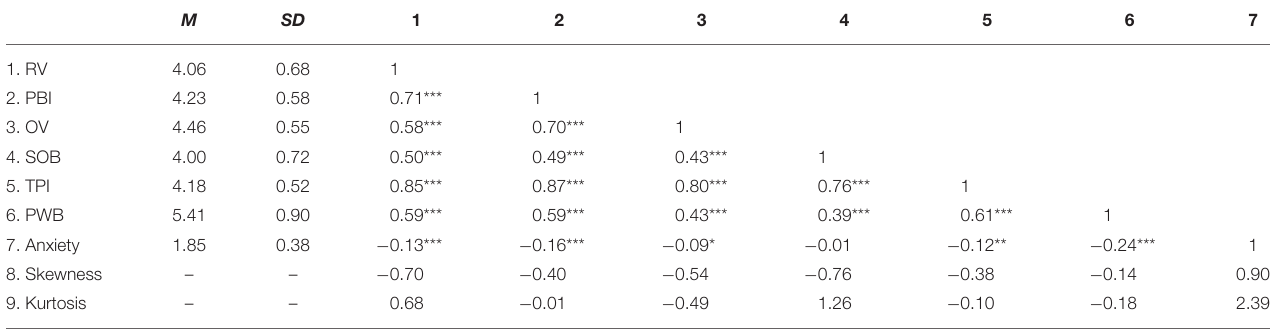
TABLE 1 | Means, standard deviations, and correlations of the main study variables.